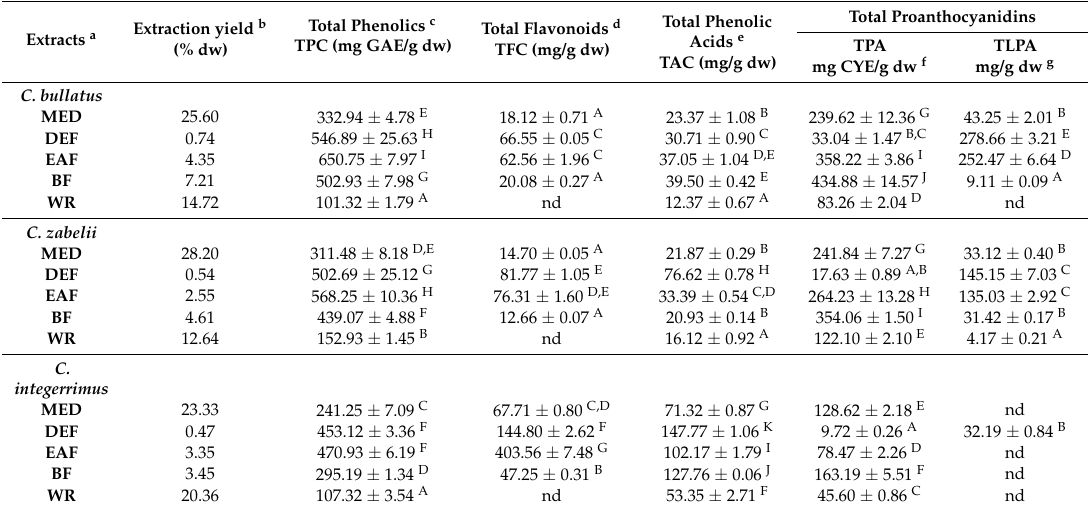
Table 1. Total phenolic content and total contents of flavonoids, phenolic acids and proanthocyanidins in the Cotoneaster leaf dry